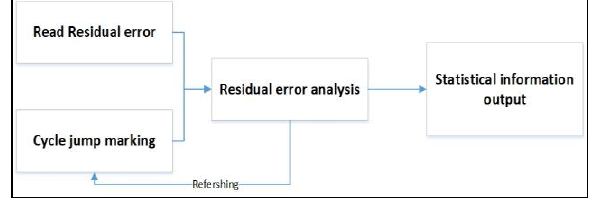
Figure3 . Residual error editing process